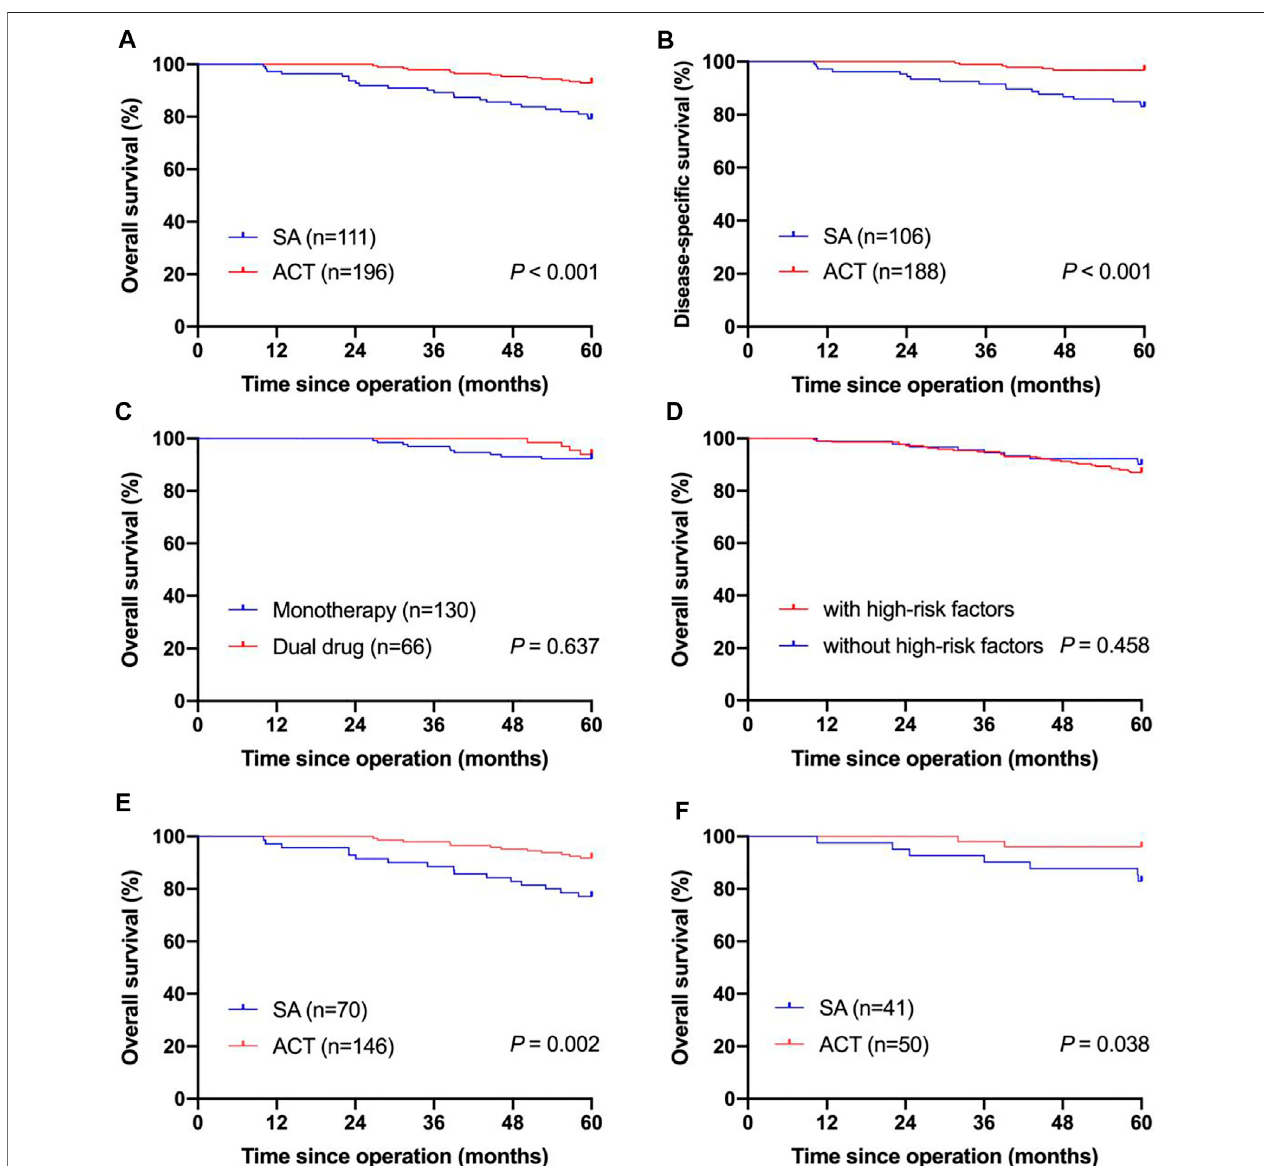
FIGURE2| Kaplan-Meier curvesforsurvivalofpT2N0M0gastriccancerpatients. (A) Kaplan-MeiercurvesofpT2N0M0gastriccancerpatientsunderwentSAand patients receiving ACT in the OS analysis; (B) Kaplan-Meier curves of pT2N0M0 gastric cancer patients underwent SA and patients receiving ACT in the DSS analysis; (C) Kaplan-Meier curves of pT2N0M0 gastric cancer patients who received monotherapy and patients who received the dual-drug regimen in the OS analysis; (D) Kaplan-MeiercurvesofpT2N0M0gastriccancerpatientswithhigh-riskfactorsandpatientswithouthigh-riskfactorsintheOSanalysis; (E) Kaplan-Meiercurvesof pT2N0M0 gastric cancer patients with high-risk factors who underwent SA and who received ACT in the OS analysis; (F) Kaplan-Meier curves of pT2N0M0 gastric cancer patients without high-risk factors who underwent SA and who received ACT in the OS analysis; SA, surgery alone; ACT, adjuvant chemotherapy; OS, overall survival; DSS, disease-speci fi c